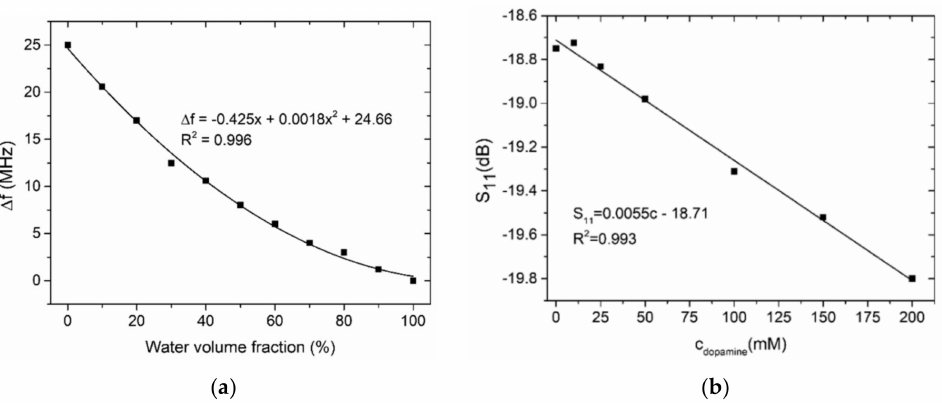
Figure 17. The changes of the resonance frequency for different water contents in the ethanol–water solutions ( a ) and the changes of reflectance S 11 for various concentrations of dopamine in the buffer ( b )